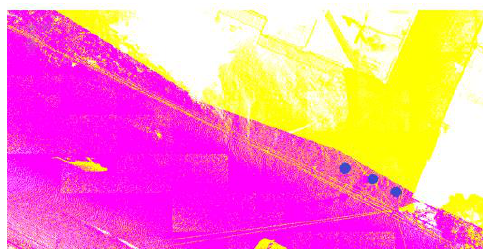
Figure 14. Approximate location of manual control point triplet